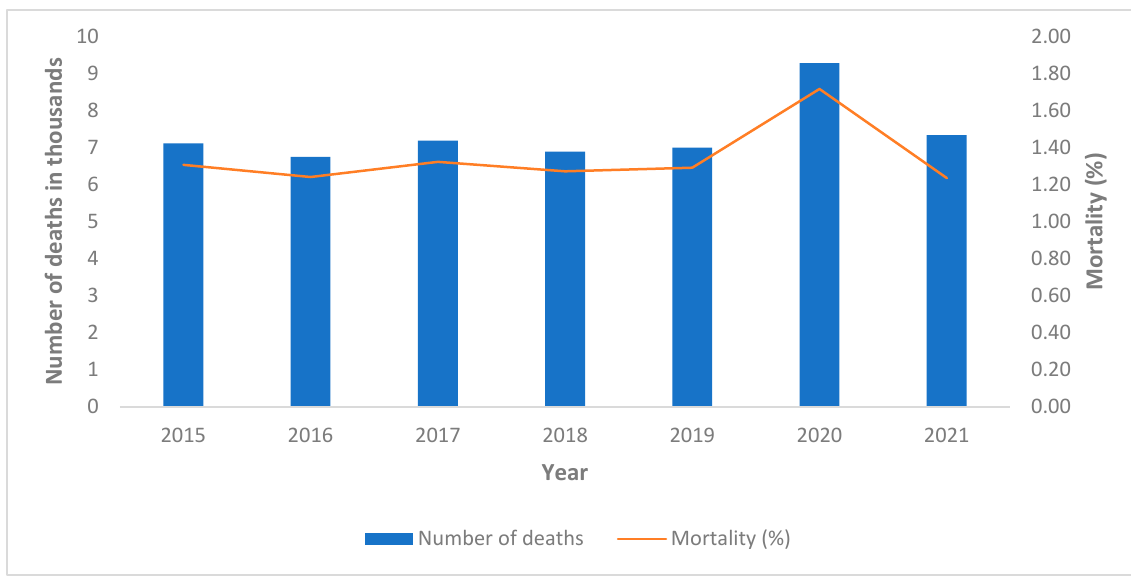
Figure 4. Number of deaths among physicians and dentists in the province of Pavia. (c): All Doctors, (d): Physicians, (e): Dentists, (f): Physicians-Dentists, (g): All Dentists. While in Italy the mortality rate in 2020 was 1.25% with an increase of 16.37% compared to the previous 5 years, in the province of Pavia the mortality rate in the same year was 1.72% with an increase of 33.43% compared to the previous year (Figures 2 and 3). Mortality of all the physicians and dentists (c) went from 0.49% in the 5 years preced- ing the epidemic, to 0.83% in 2020 and then dropped to 0.43% in 2021 (Figure 4). Popula- tion data cannot be directly compared with those of physicians and dentists because the groups are made up of a population of different ages. The data, relating to the number of deaths among physicians and dentists, shows a peak in the number of deaths relative to 2020, and in particular to April 2020 (data not shown). In absolute terms, the highest number of deaths was observed among physicians (d), followed by physicians-dentists (f) (Figure 4). Moving on to analyze the mortality rate, a peak was observed in 2020 in all groups of doctors (c,d,f,g) with the exception of dentists (e) (Figure 5). In particular, the highest